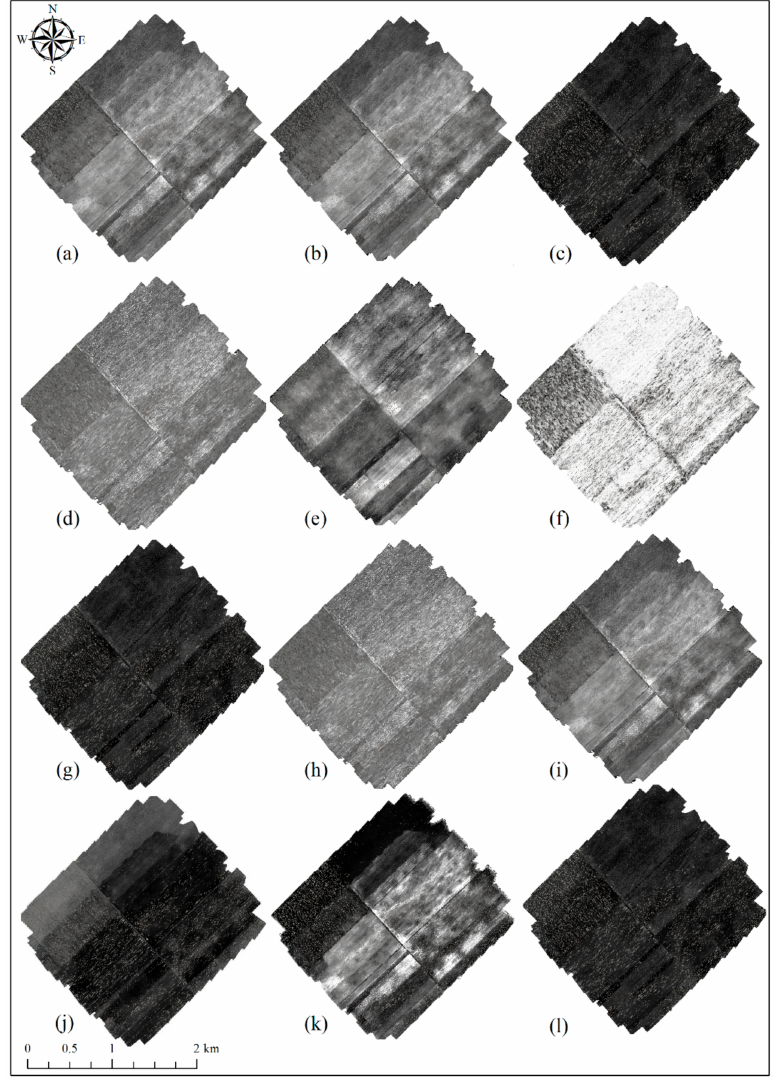
Figure 9. Application of features functions on the mosaicked UAV images: (a) red, ( b ) green, ( c ) blue, ( d ) Std.Dev red, ( e ) Std.Dev green, ( f ) brightness, ( g ) Std.Dev blue, ( h ) GLCM correlation, ( i ) GLCM homogeneity, ( j ) GLCM contrast, ( k ) GLCM mean, and ( l ) GLCM